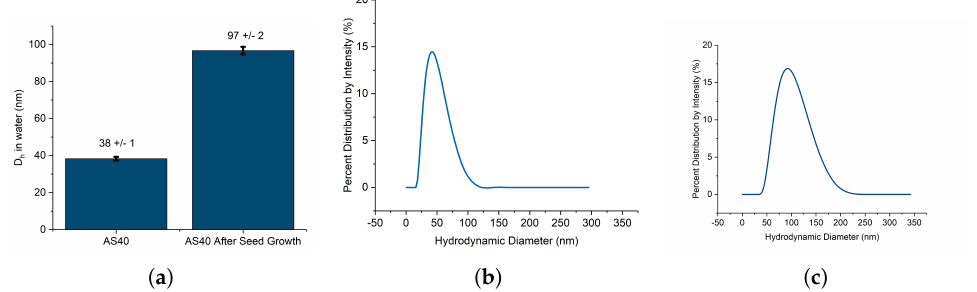
Figure A2. Change in hydrodyanamic size of Ludox AS40 after seed-growth. Measurements con- ducted for particles diluted in MilliQ water after washing and dialysing. ( a ) Comparison of intensity average Dh before and after seed-growth. ( b ) Hydrodyanmic size distribution of Ludox AS40 before seed-growth synthesis. D h = 38 ± 1 ( c ) Hydrodynamic size distribution after seed-growth synthesis. D h = 97 ± 2.